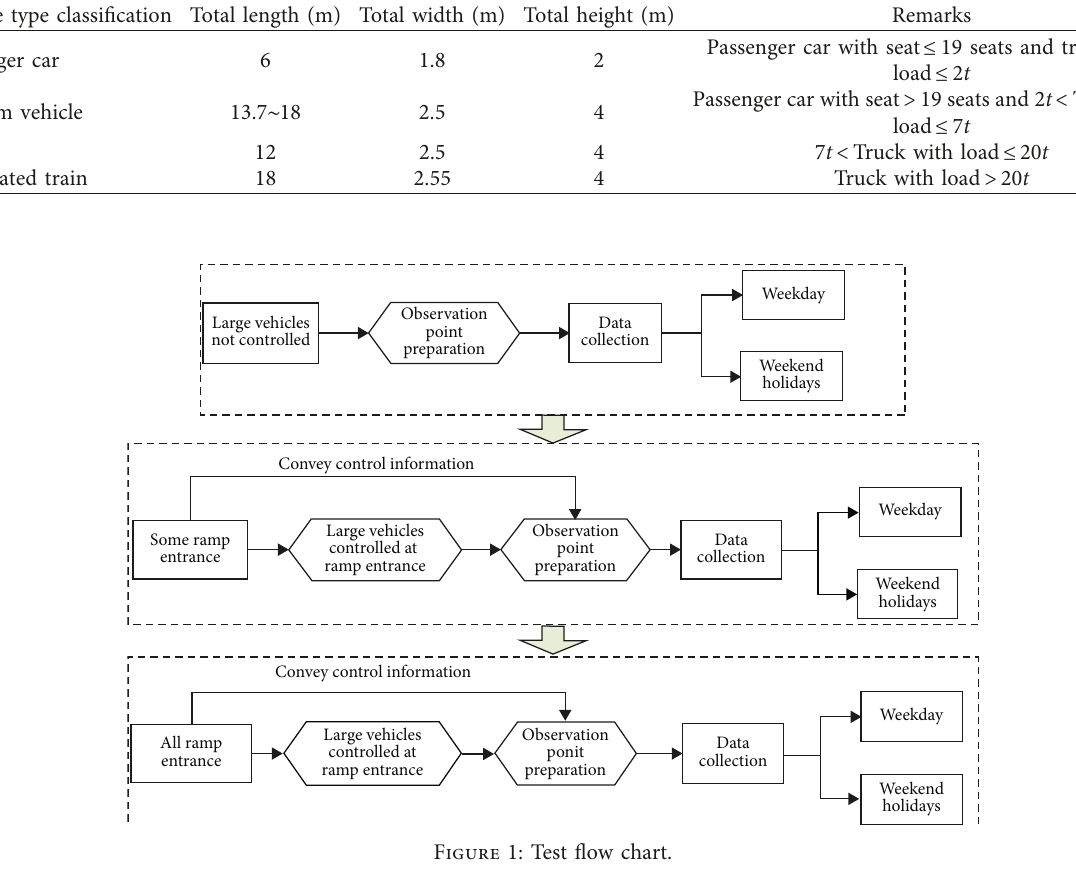
Table 1: Car exterior size classification.